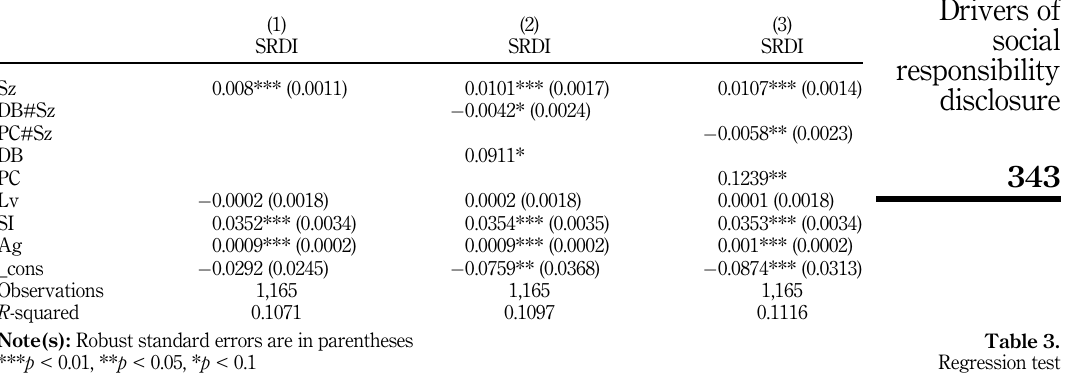
Table 3. Regression